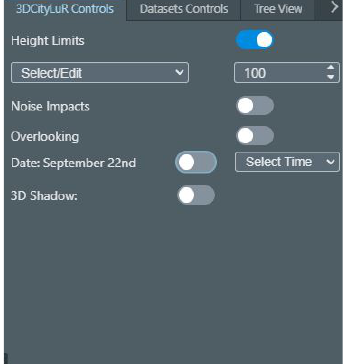
Figure 7 . Modelling control tools in iTwin4PP.